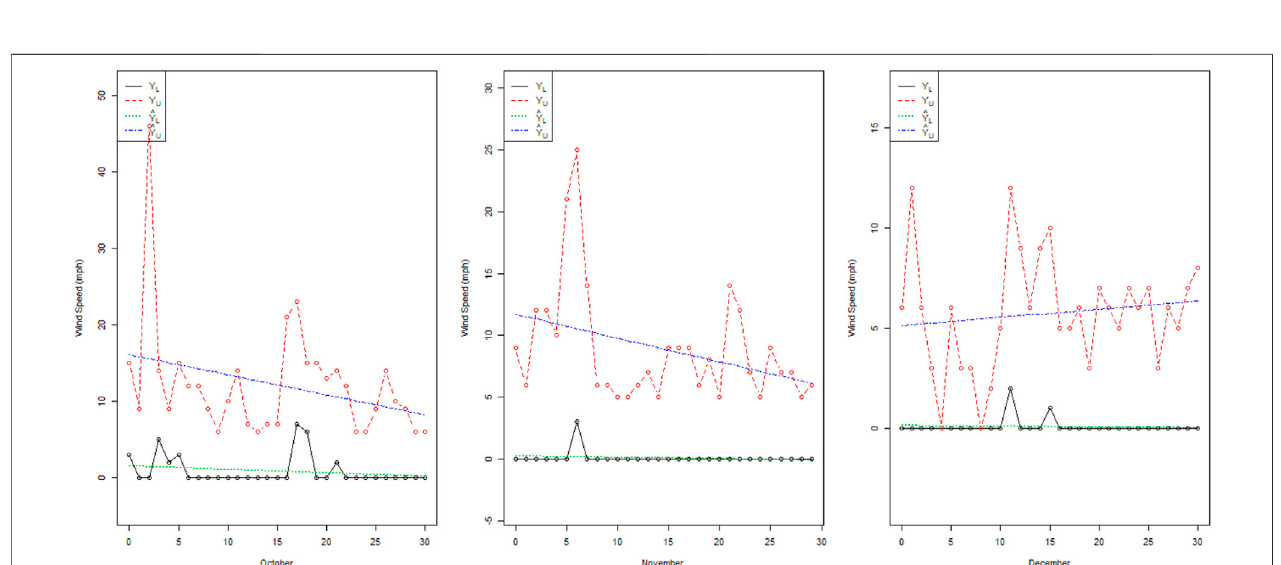
FIGURE 5 | Trended lines for October, November, and